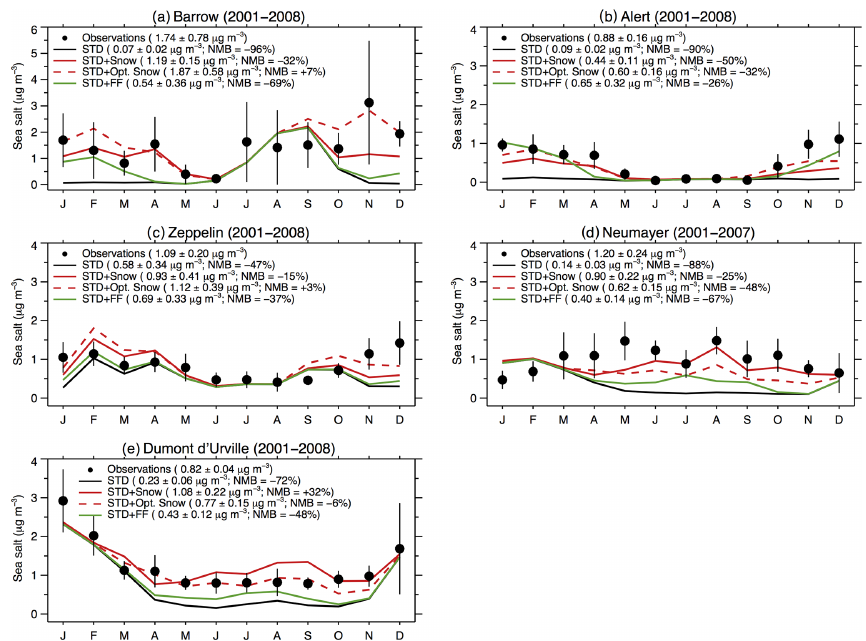
Figure 6. Monthly mean SSA mass concentrations at Arctic sites ( a : Barrow, b : Alert, c : Zeppelin) and Antarctic sites ( d : Dumont d’Urville, e : Neumayer). All observations and model results are for 2001–2008, except at Neumayer (2001–2007). The observed mean concentra- tions are indicated with filled black circles, and the lines are for the GEOS-Chem simulations (STD: black line, STD + Snow: red line, STD + Opt. Snow: red dashed line; STD + FF: green line). The black vertical lines are the standard deviations of monthly means for the ob- servation years. For each individual panel, we list the cold season (Arctic: November–April; Antarctic: May–October) mean concentrations and standard deviations as well as the